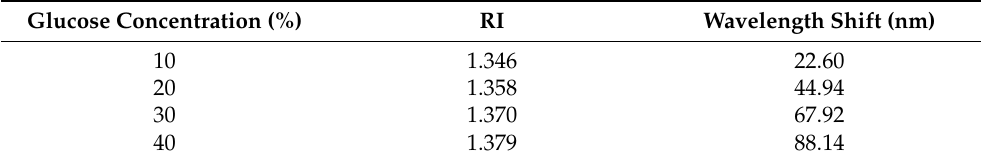
Table 1. RI values and resonance wavelength shift corresponding to each glucose solution concentration.